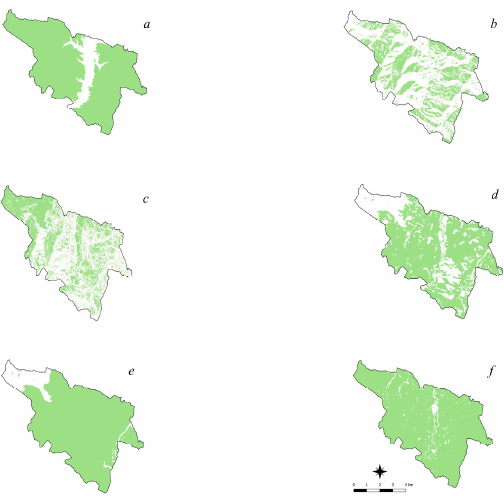
Figure 4. Suitable areas (green colour) in terms of altitude ( a ), exposure ( b ), slope gradient ( c ), soil type ( d ), geolithology ( e ), and land use ( f ) for the cultivation of chestnut stands for fruit production in Castel del Rio, Emilia ‐ Romagna Region, Italy.